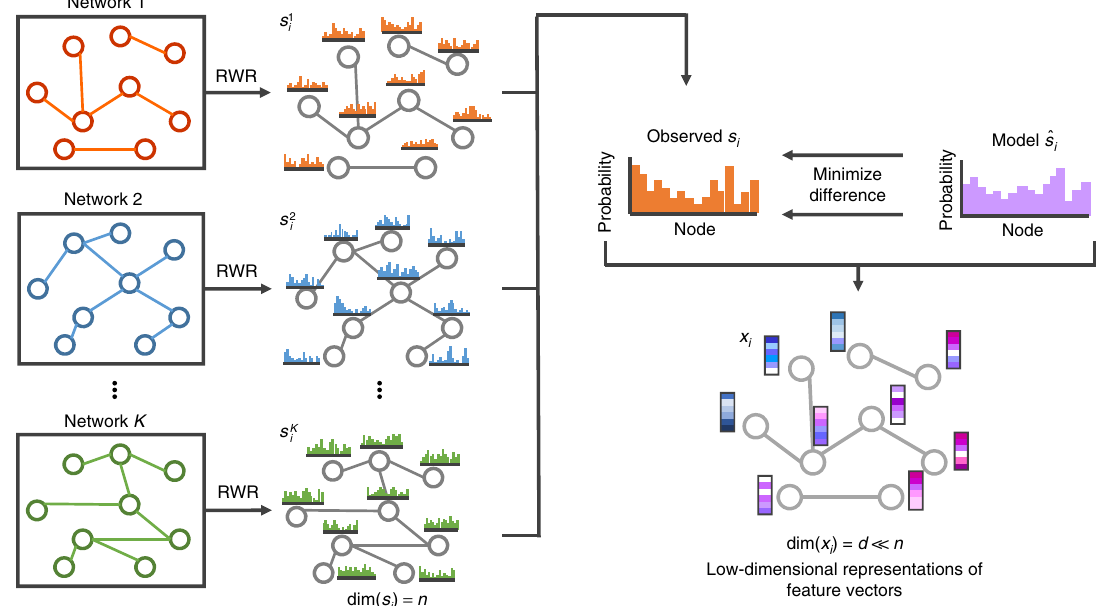
Fig. 2 Schematic illustration of compact feature learning. The random walk with restart (RWR) algorithm is fi rst used to compute the diffusion states of individual networks. Then the low-dimensional representations of feature vectors for individual nodes are obtained by minimizing the difference between the diffusion states s i and the parameterized multinomial logistic models ^ s i . The learned low-dimensional feature vectors encode the relational properties (e.g., similarity), association information and topological context of each node in the heterogeneous network. More details can be found in the main